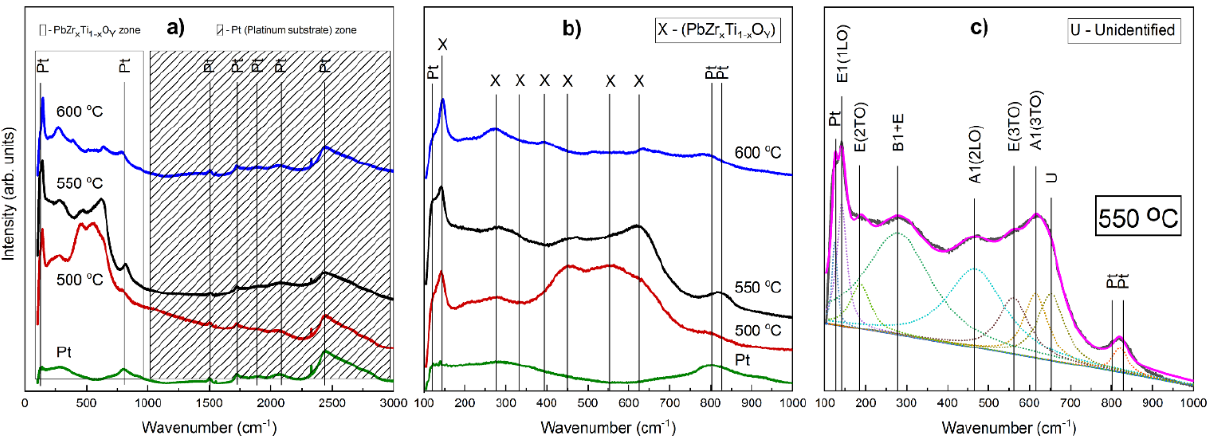
Figure 3. Raman spectra of PZT thin films deposited at 500, 550 and 600 °C temperatures and substrate (Pt/Ti/SiO 2 /Si). ( a ) Wide-scan spectra; ( b ) narrow; ( c ) fitted spectrum of the film deposited at 550 °C temperature.